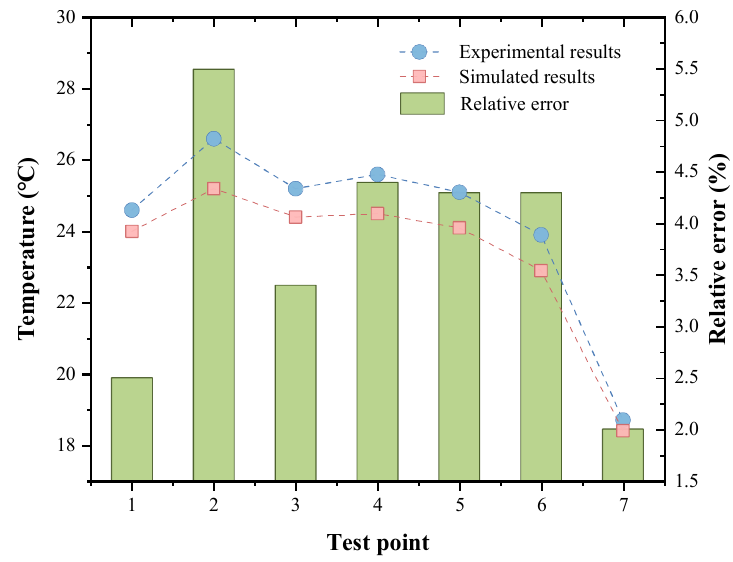
Figure 7. Comparison of measured and simulated results.